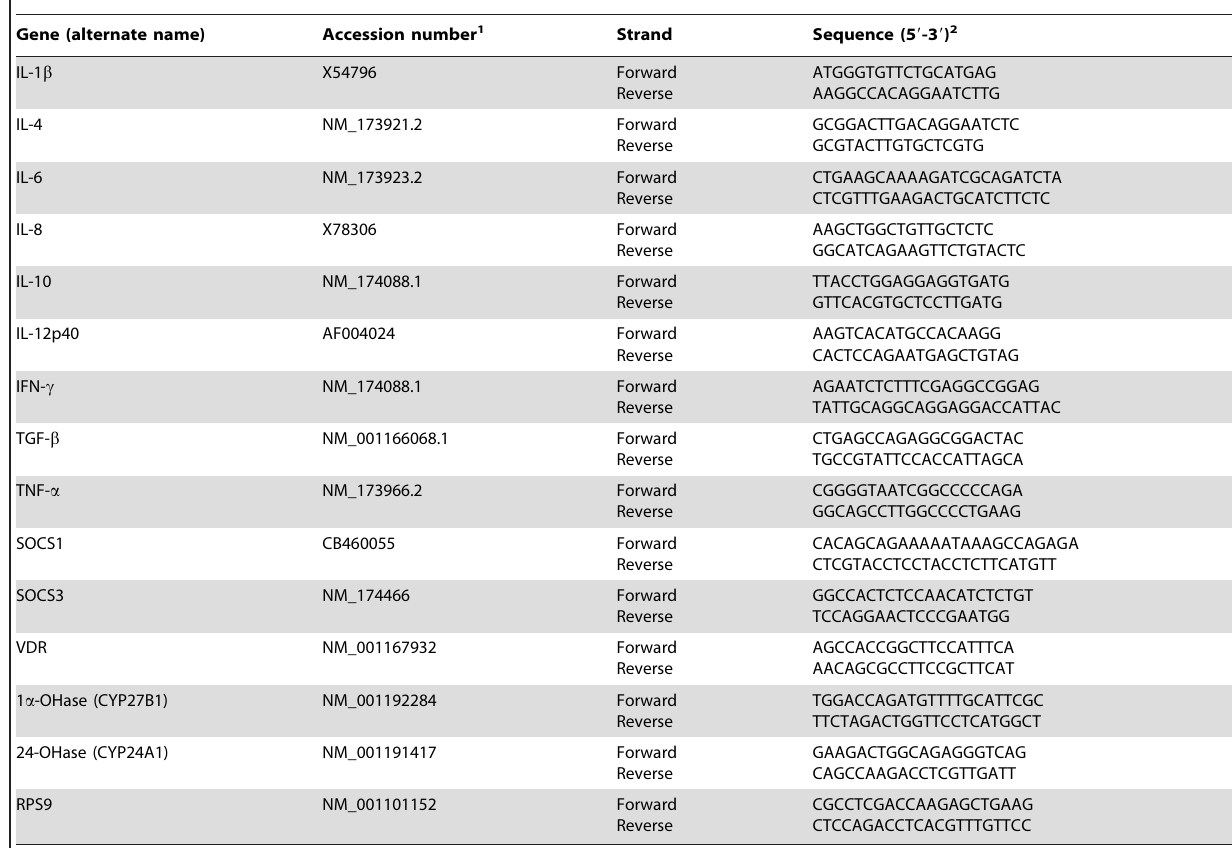
Table 1. Primers used in the present